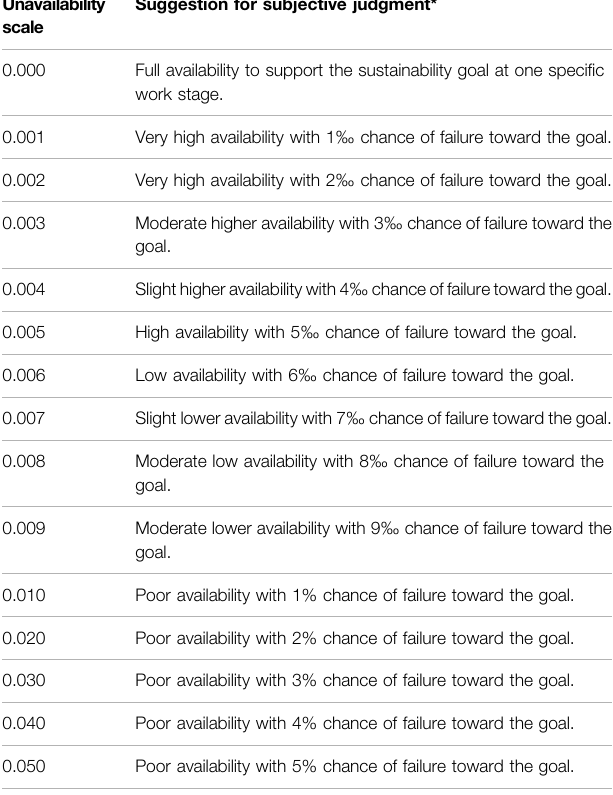
TABLE 10 | Table of unavailability upon megaproject sustainability. Unavailability